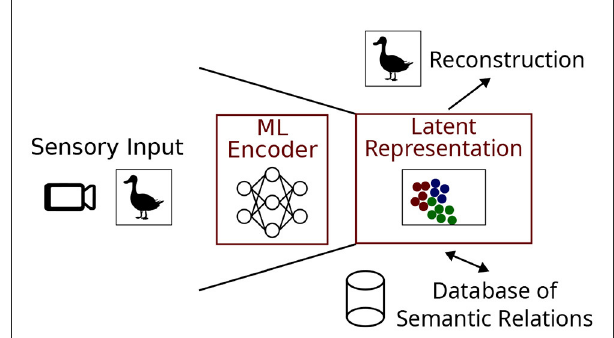
TABLE 1 Comparison of online clustering